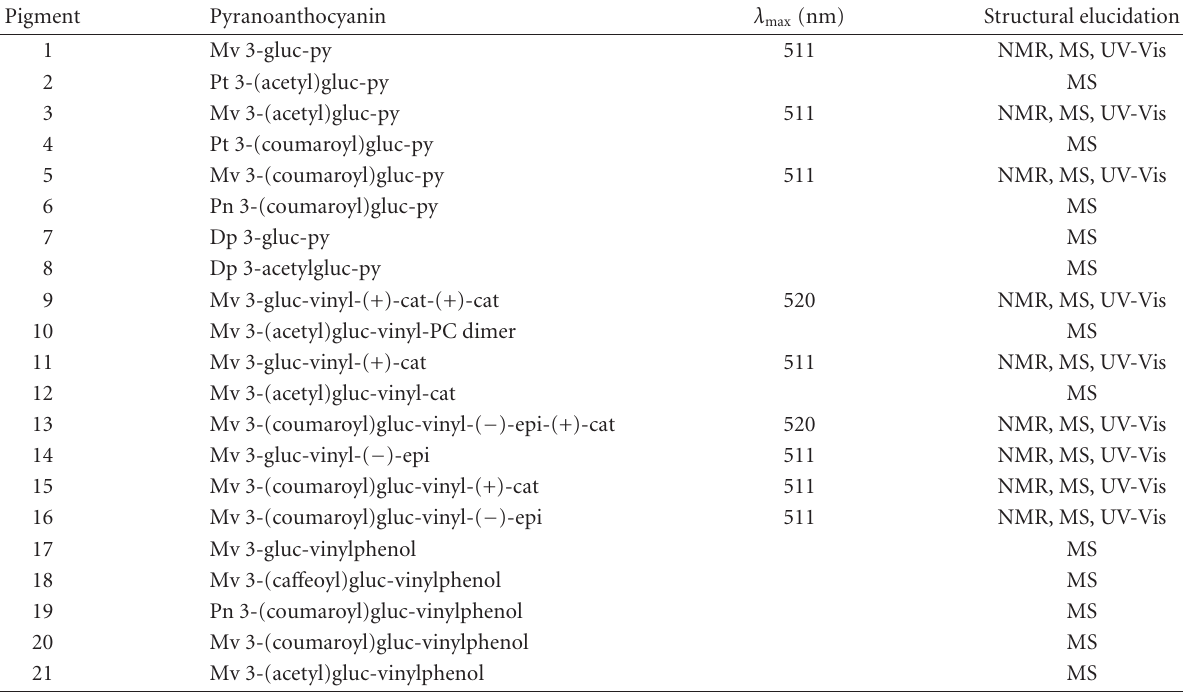
Table 1. Pyranoanthocyanins and detected in Port wine fractions. (Mv = malvidin; Dp = delphinidin; Pt = petunidin; Pn = peonidin; py = pyruvic acid derivative; gluc = glucoside; cat = (+)-catechin or ( − )-epicatechin; PC = procyanidin